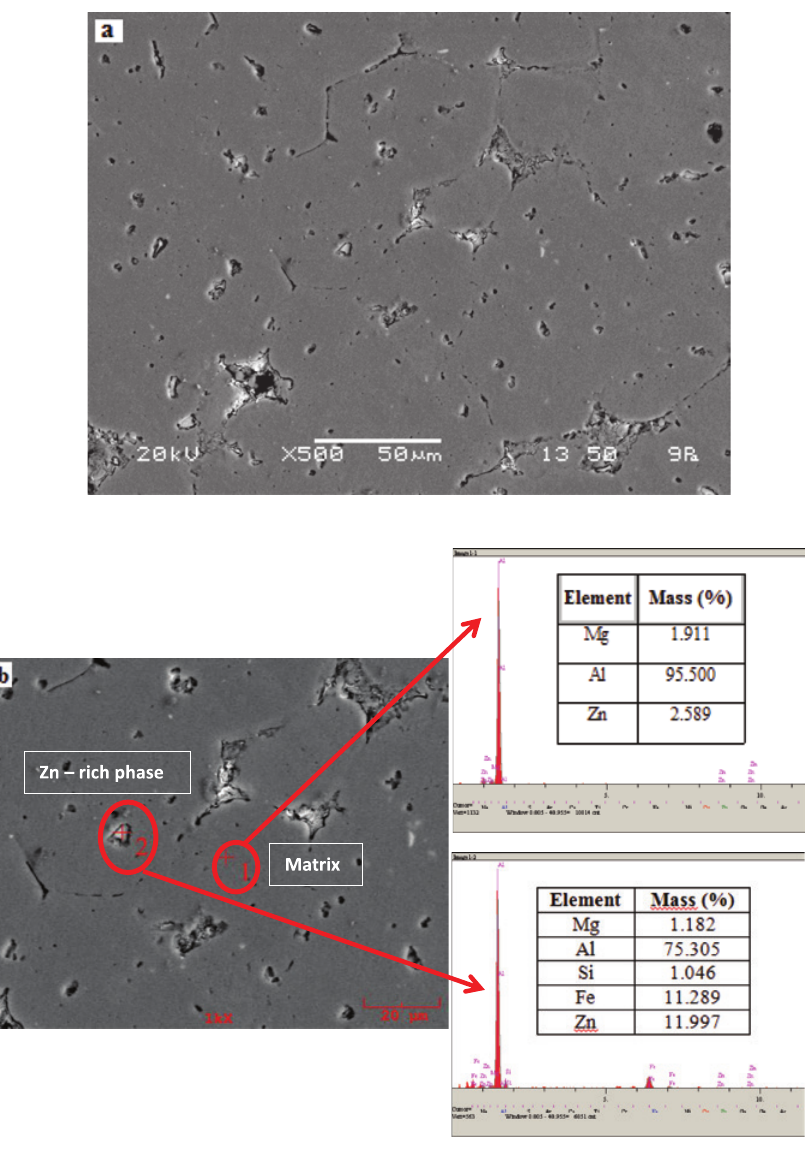
Fig. 3: The SEM Microstructure of the thixoformed AA7075 (a), EDS graphic